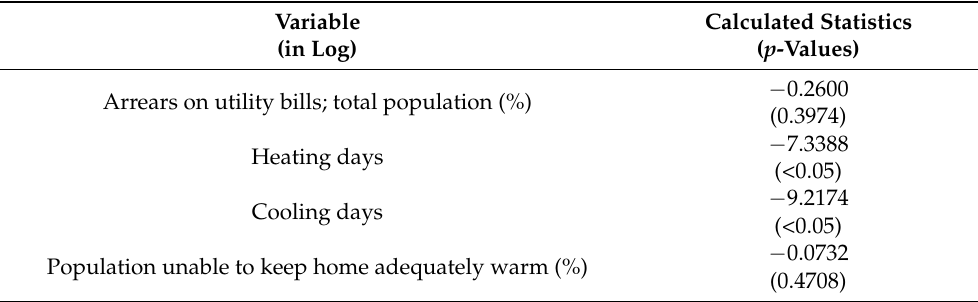
Table 3. The results of Im-Pesaran-Shin test for unit roots in panel